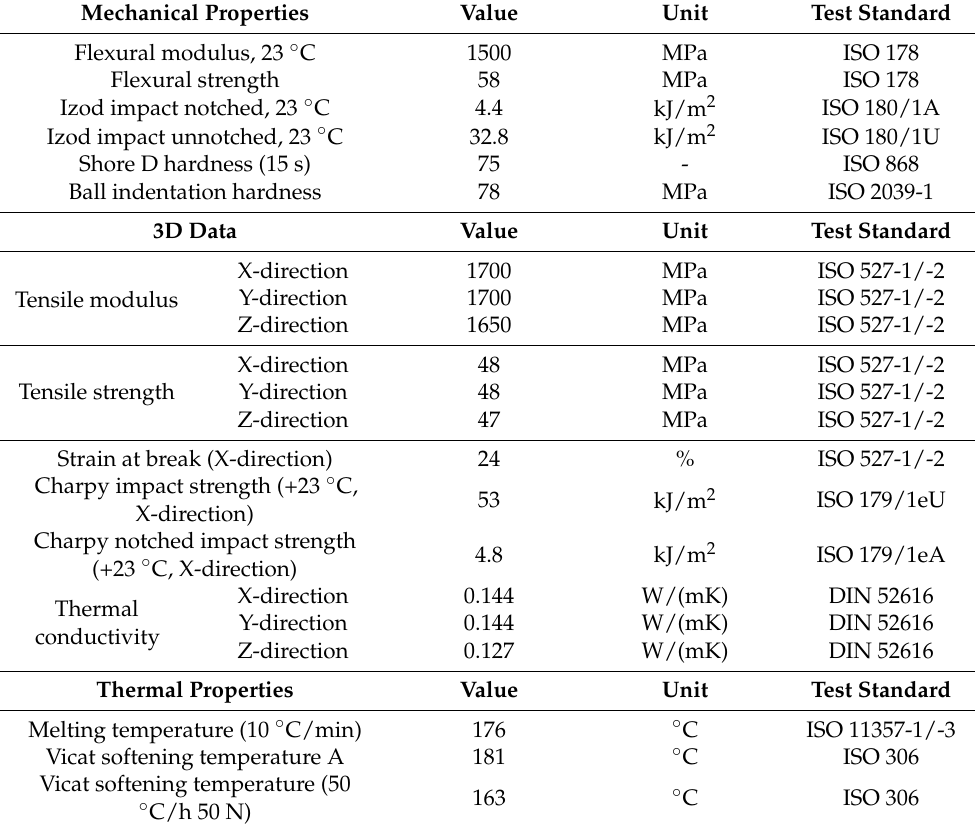
Table 1. Mechanical and thermal characteristics of PA 2200 [49].